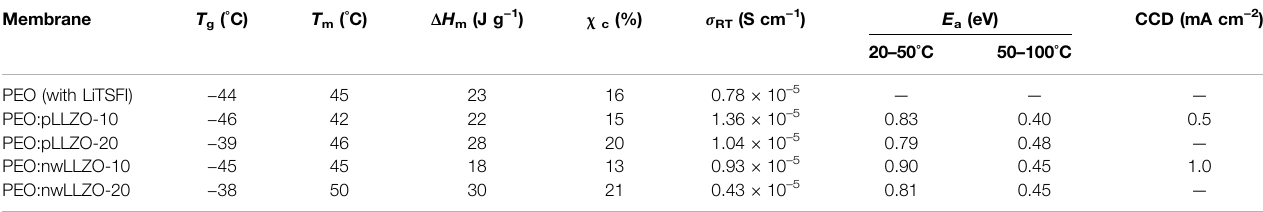
TABLE 1 | Results from DSC, EIS, and galvanostatic cycling.